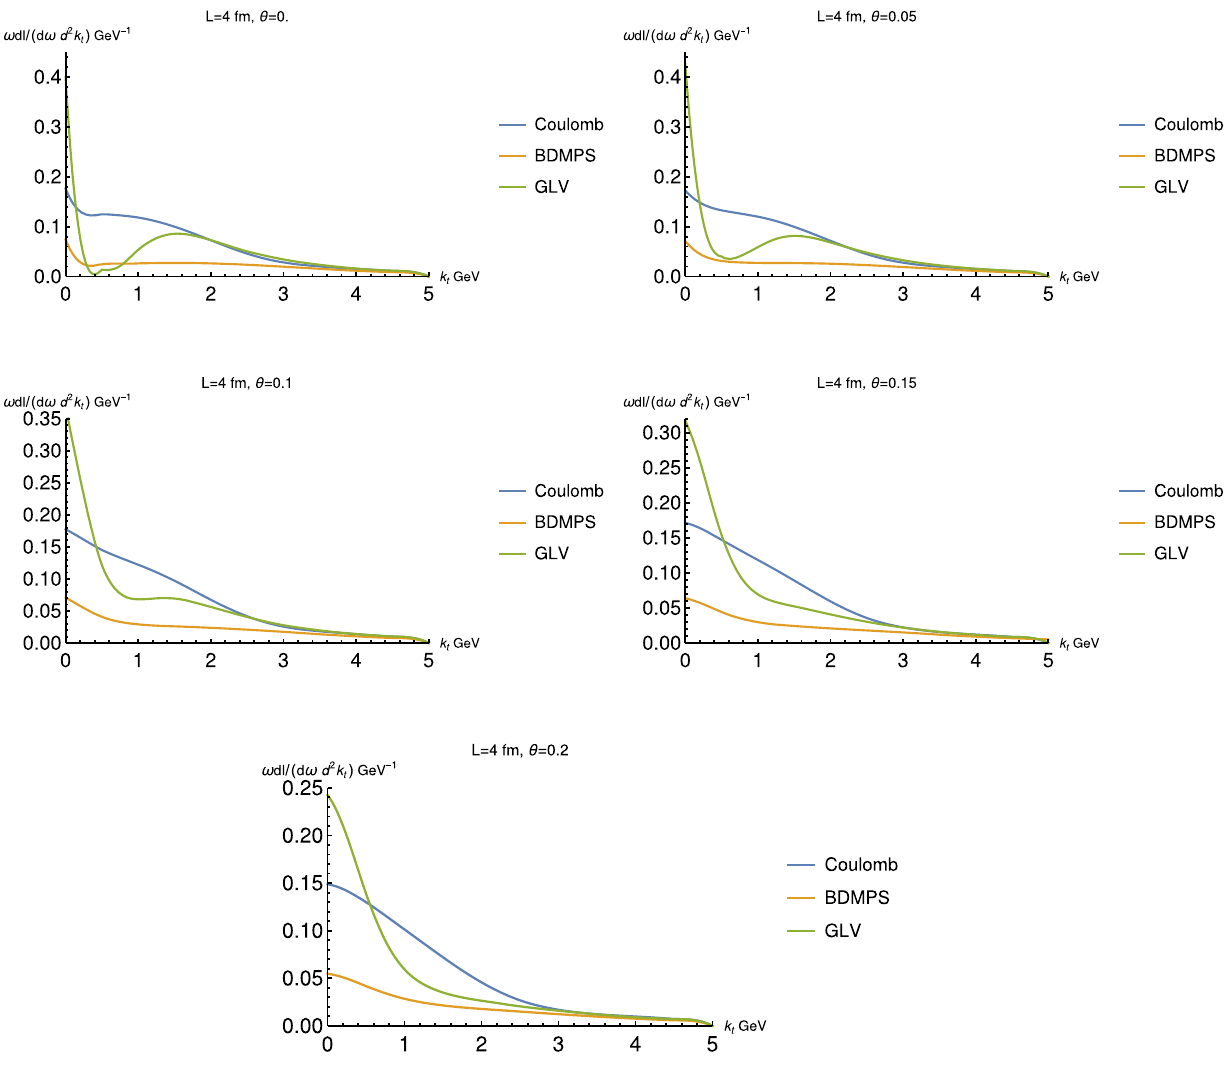
Oscillator approximation given by Eq. (42), Coulomb means the angu- lar distribution in the Moliere theory given by Eq. (41). All graphs here and below are presented divided by α s C